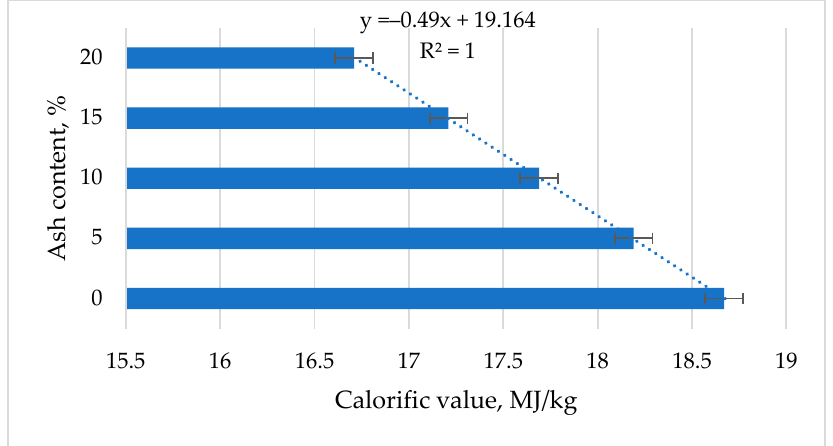
Figure 8. The influence of the ash content on the calorific value.